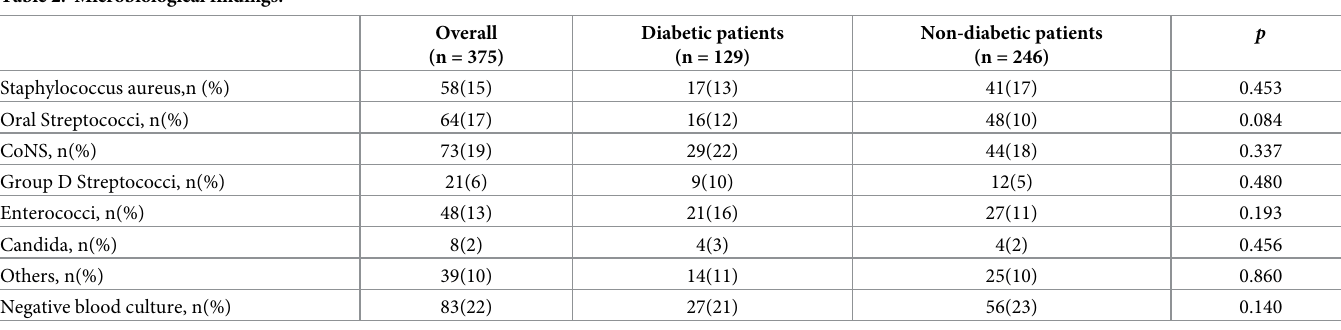
Table 2. Microbiological